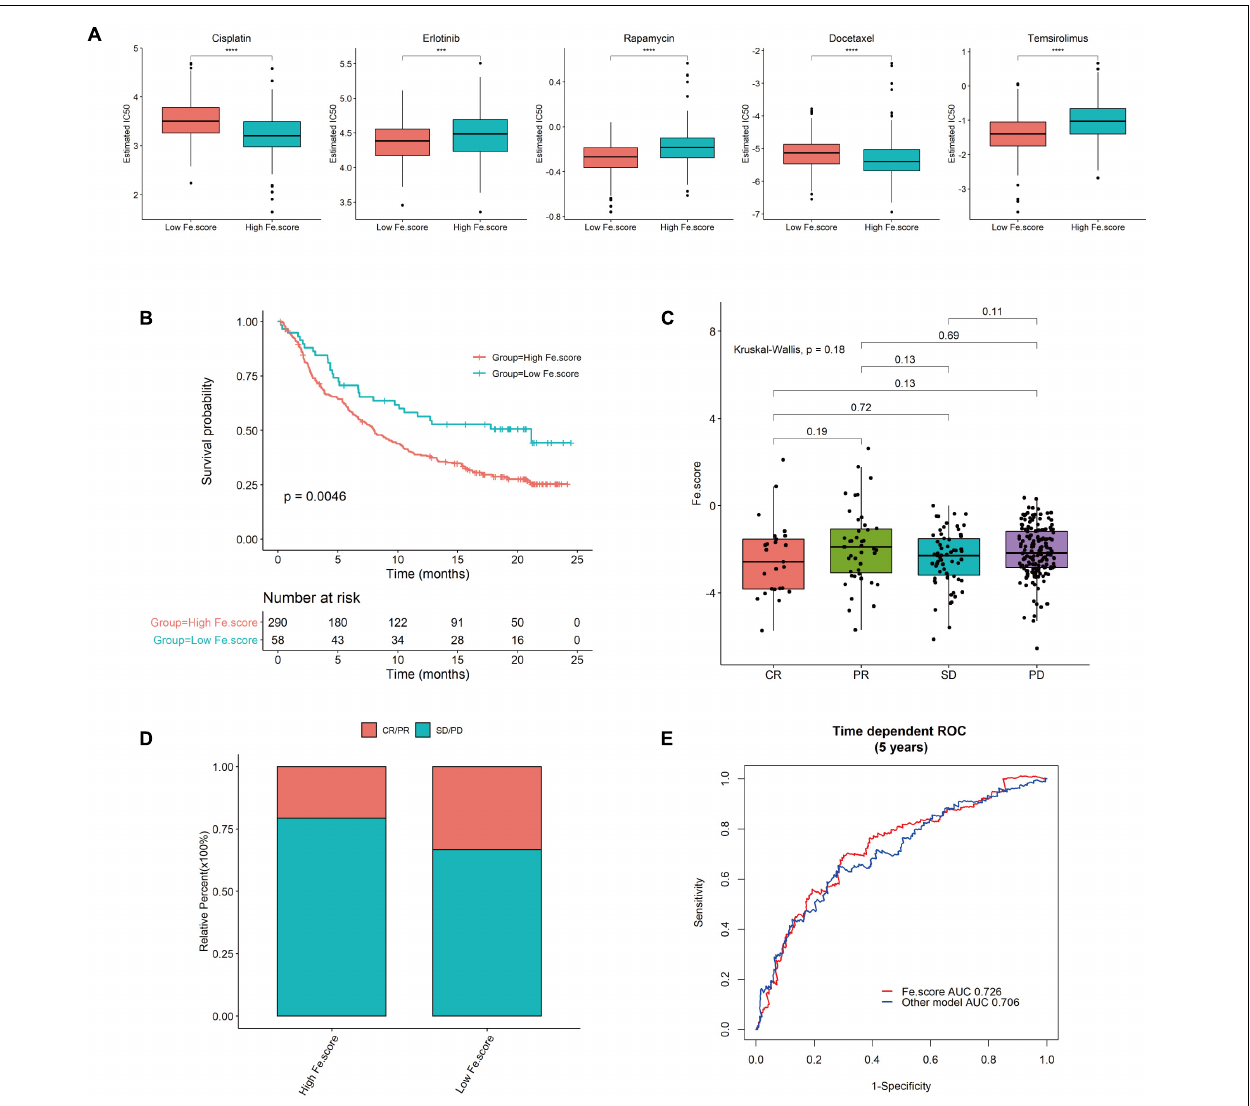
FIGURE 8 | Immunotherapy results in the high- and low-Fe.score groups. (A) GDSC predicts the IC50 difference of five drugs between Fe.score groups. (B) Kaplan–Meier survival curve between Fe.score groups in the bladder cancer dataset (IMvigor210). (C) The proportion of CR/PR and SD/PD between Fe.score groups. (D) The differences in Fe.score among CR, PR, SD, and PD. (E) Fe.score 5-year receiver operating characteristic curve compared with other prognostic models of endometrial